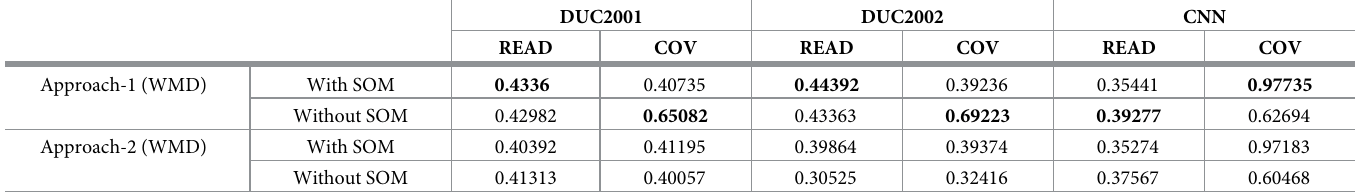
Table 5. Average readability and coverage scores of the summaries obtained by our proposed approaches utilizing WMD on three datasets. Here, the used summaries are obtained using SMaxRouge